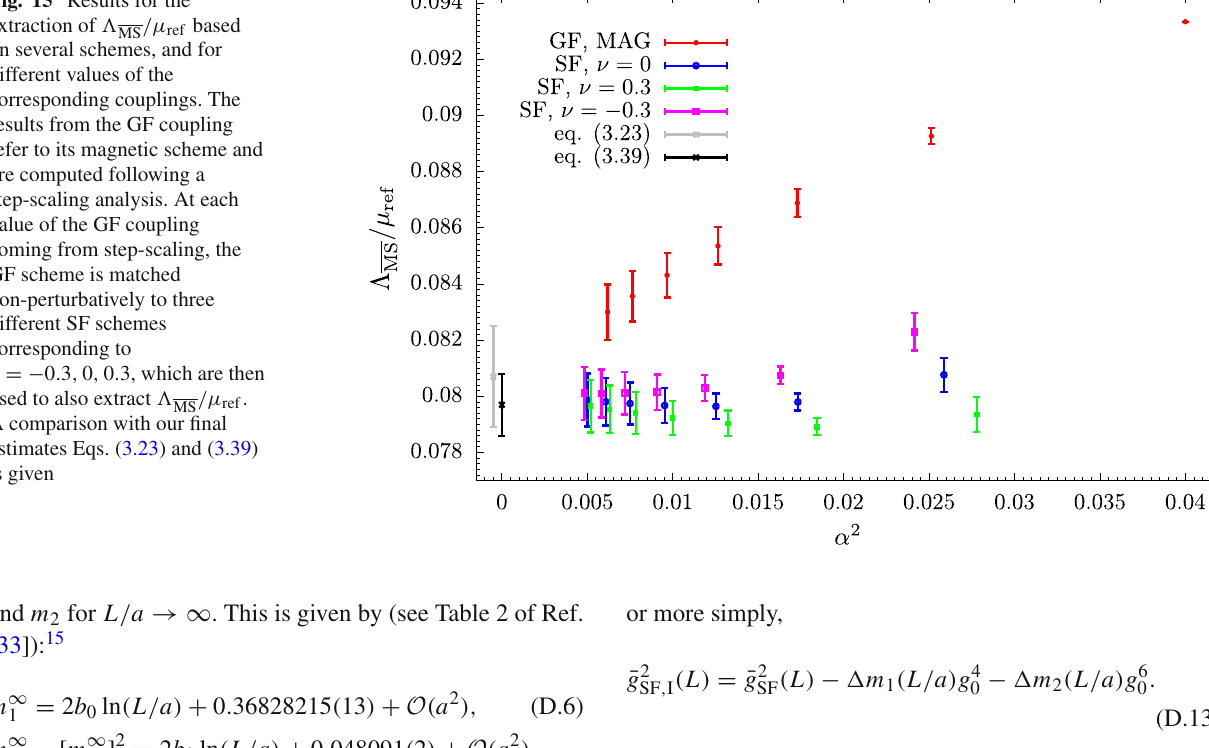
Fig. 15 Results for the /μ extraction of (cid:3) ref based MS on several schemes, and for different values of the corresponding couplings. The results from the GF coupling refer to its magnetic scheme and are computed following a step-scaling analysis. At each value of the GF coupling coming from step-scaling, the GF scheme is matched non-perturbatively to three different SF schemes corresponding to ν = − 0 . 3 , 0 , 0 . 3, which are then /μ used to also extract (cid:3) ref . MS A comparison with our final estimates Eqs. (3.23) and (3.39) is given